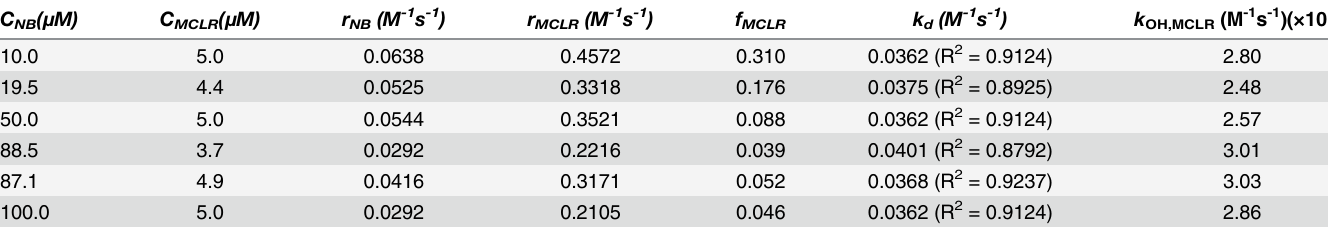
Table 1. Parameters determined under different nitrobenzene concentrations.